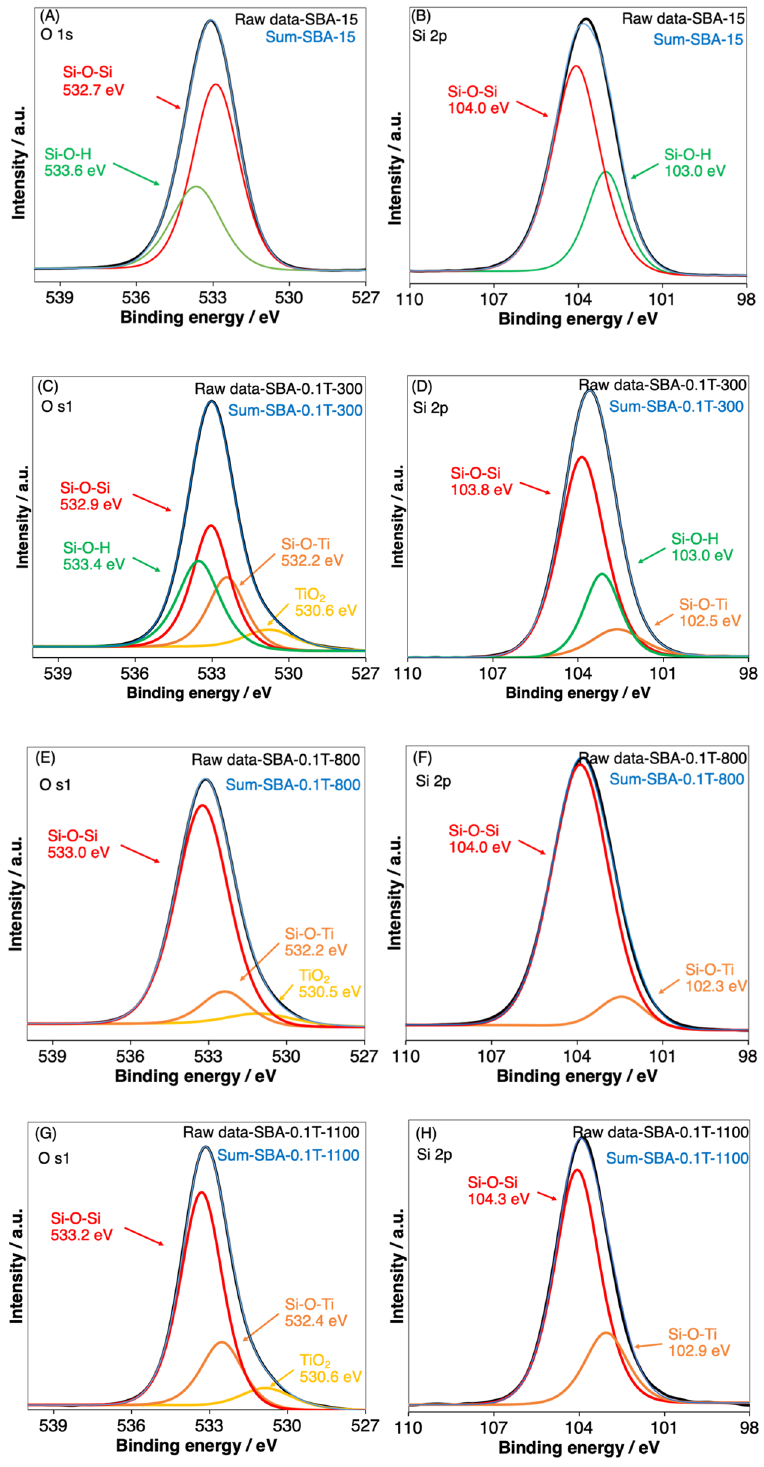
Figure 10. XPS spectra of ( A , B ) SBA-15, ( C , D ) SBA-0.1 T-300, ( E , F ) SBA-0.1 T-800 and ( G , H ) SBA-0.1 T-1100 which respected with O1s and